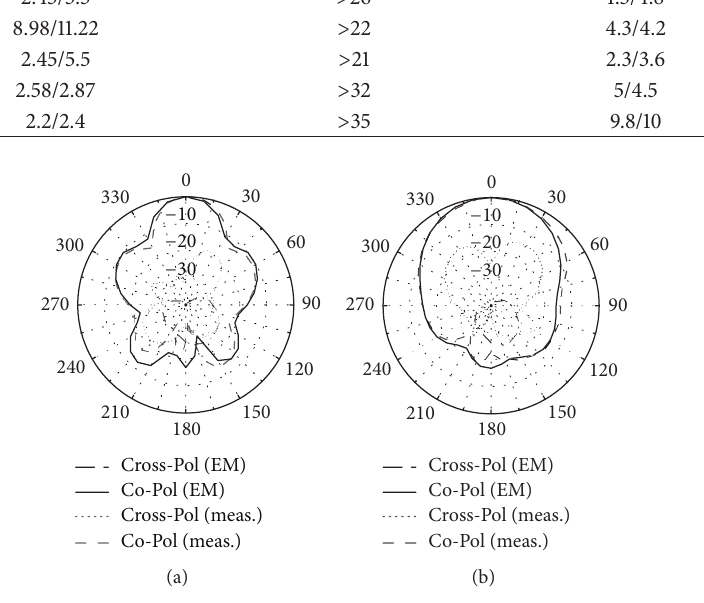
Figure 11: Normalized radiation patterns at 2.2 GHz for port 1 excited: (a) 𝜑 = 90 ∘ ; (b) 𝜑 = 0 ∘ .